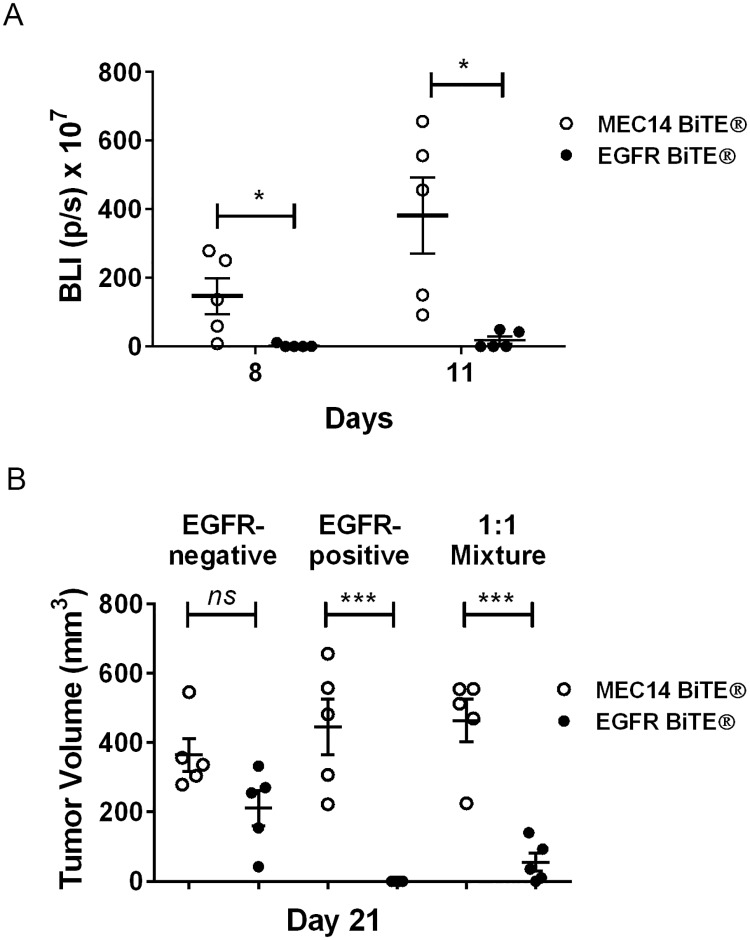
Lysis of bystander EGFR-negative tumor cells in tumor xenografts.Luciferase-labeled EGFR-negative cells (SW620-LUC), EGFR-positive cells (HCT116) or equal numbers of each cell line were mixed with human T cells (E:T 1:1, where the number of T cells is equal to the number of total combined target cells in mixed implants) and implanted in immunocompromised mice. MEC14 negative control BiTE® or EGFR BiTE® was dosed once daily. (A) Tumor growth for 1:1 mixture implants was measured by luminescence on days 8 and 11 using an imaging system. (B) Tumor volume was measured with calipers on day 21. Data represent averages of 5 replicate animals +/- SEM. Significance values: ns, P > 0.05; *P < 0.05; **P < 0.01; ***P < 0.001; ****P < 0.0001.